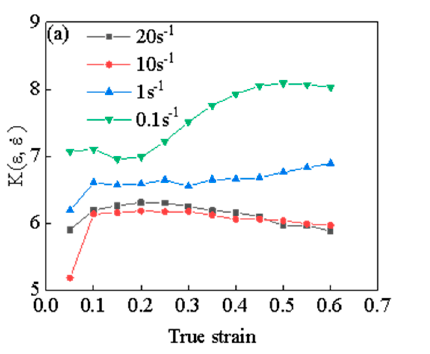
. Figure 13. The value of K ( ε , ε ) under different deformation conditions: ( a ) the calculation results, Figure 13. The value of K ( ε , 𝜀(cid:4662) ) under different deformation conditions: ( a ) the calculation results, ( b ) the fitting results. ( b ) the fitting results According to Equation (14), assuming the function value of 𝑏(𝜀, 𝑇) is equal to the function value of lnA(𝜀, 𝜀(cid:4662), 𝑇) − 𝑄(ε, 𝜀(cid:4662), 𝑇) 𝑅𝑇⁄ , thus, the value of 𝑏(𝜀, 𝑇) is the intercept of Figure 14b. The expression of fitting function 𝑏(𝜀, 𝑇) is shown in Equation (19), with the the curve ln 𝜀(cid:4662) - ln(cid:4668)sinh(cid:4670)𝛼(𝜀, 𝑇)𝜎(cid:4671)(cid:4669) under the different deformation temperatures and correlation coefficient R 2 = 0.999.